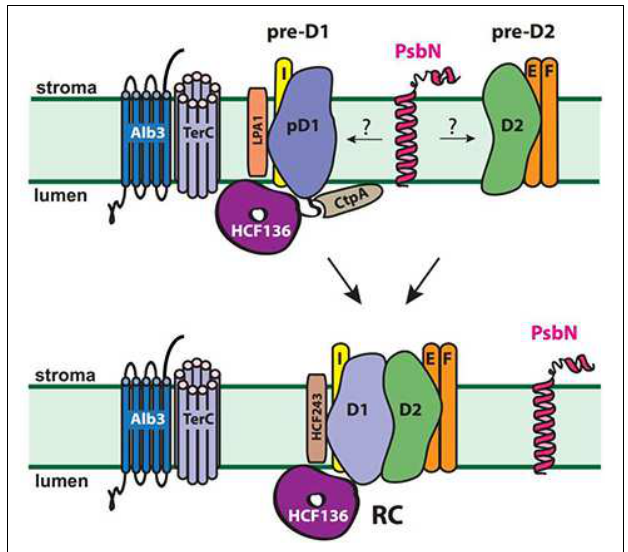
FIGURE 3 | Role of factors required for early assembly of the heterodimeric PSII reaction center complex in chloroplasts. Proposed interactions of CtpA, LPA1, HCF243 and HCF136 are shown. The interaction of PsbN with PSII precomplexes and/or other assembly factors remains to be elucidated. HCF136 assists on the lumenal side of the stroma lamellae and presumably the functional C-terminus of PsbN on the stromal side in the heterodimerisation of pre-D1 and pre-D2 to form the PSII reaction center (RC). ALB3 and TerC are required for efficient post- and co-translational insertion of proteins into the PSII complex (see Figure 4